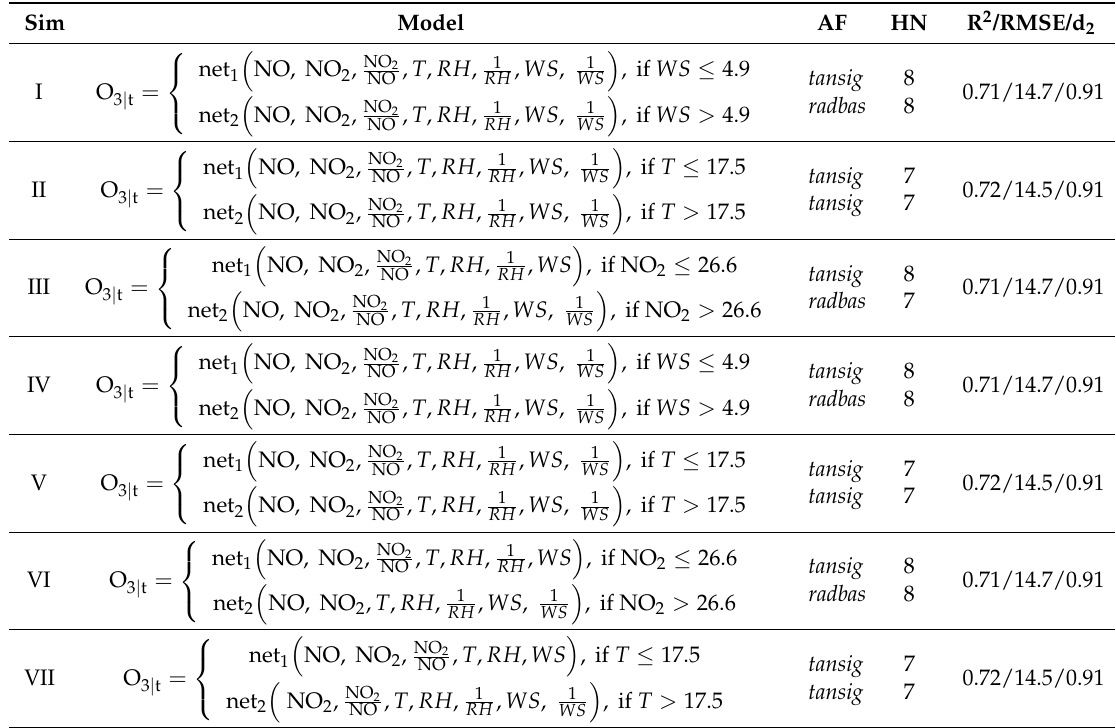
Table 1. ANN models: their input variables, activation functions (AF), number of hidden neurons (HN), and performance indexes ( R 2 , RMSE (root mean squared error) and d 2 ) for each performed simulation (Sim).